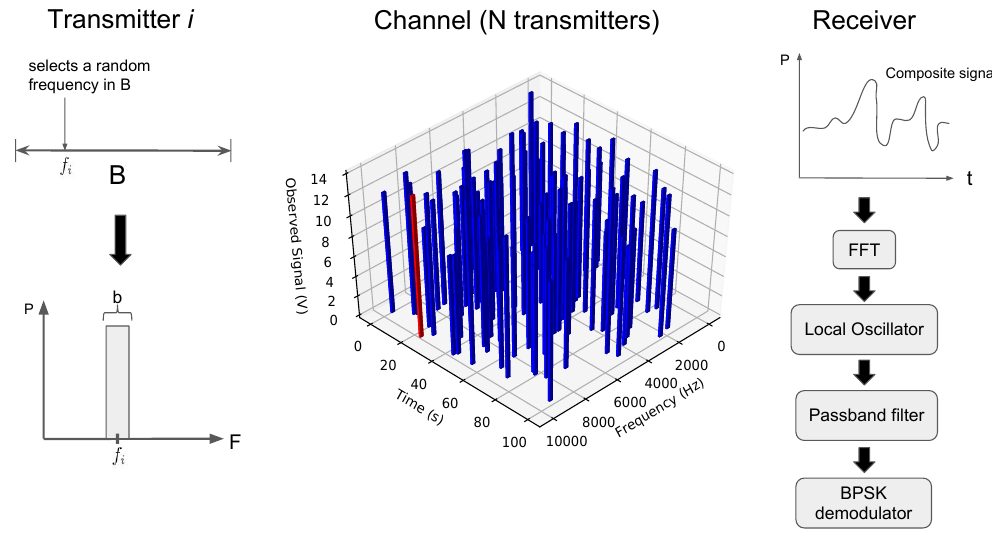
Figure 7. Random frequency time division multiple access (RFTDMA) communication process. Temporal and spectral random access from hundred of